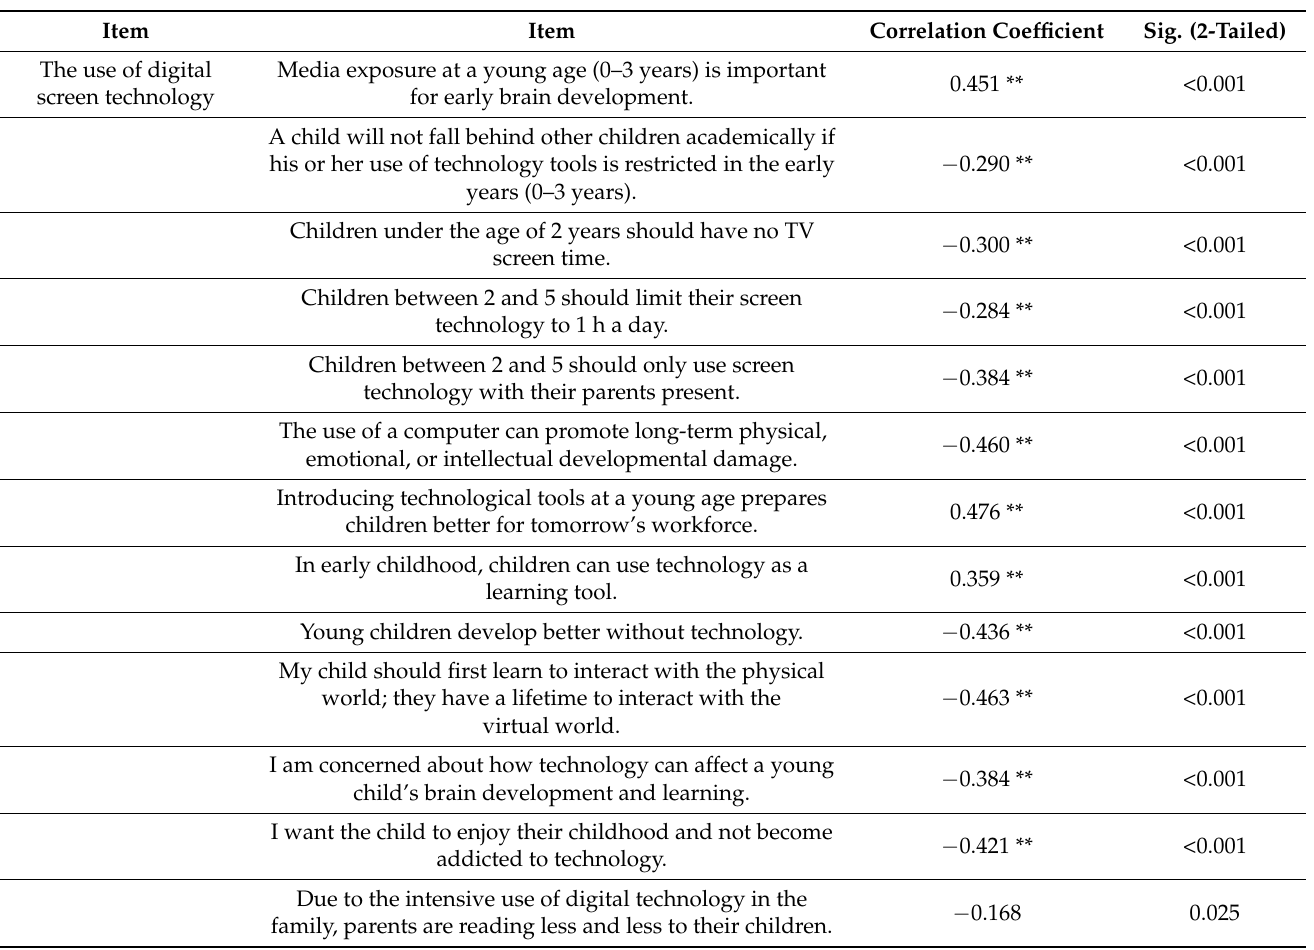
Table 1. Spearman’s correlations between the uses of digital screen technology with parents’ attitudes—the significant correlations are